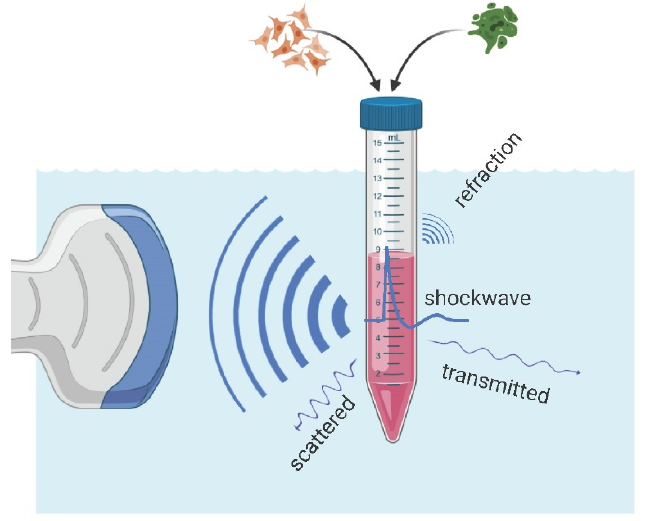
Figure 10. Schematic overview of an in vitro experimental setup. A shockwave applicator (left) generates a focusing acoustic wave which creates a strong shockwave inside the treatment zone of a biological sample. The transmitted wave is attenuated throughout by complex scattering and absorption processes resulting in important refraction phenomena in the vicinity of air–liquid- interfaces.